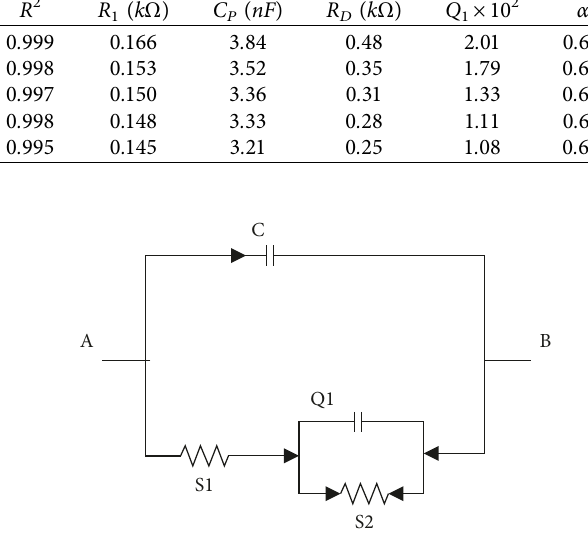
Figure 1: Electrical equivalent circuit of the sensor dipped in test sample as obtained through LEVMW [32]